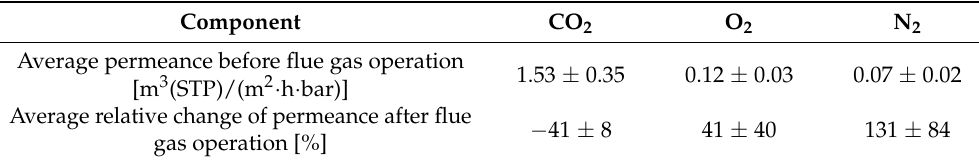
Table 7. Results of SILM envelope test before and after flue gas operation ( ϑ = 20 °C, ∆ p = 2 bar).